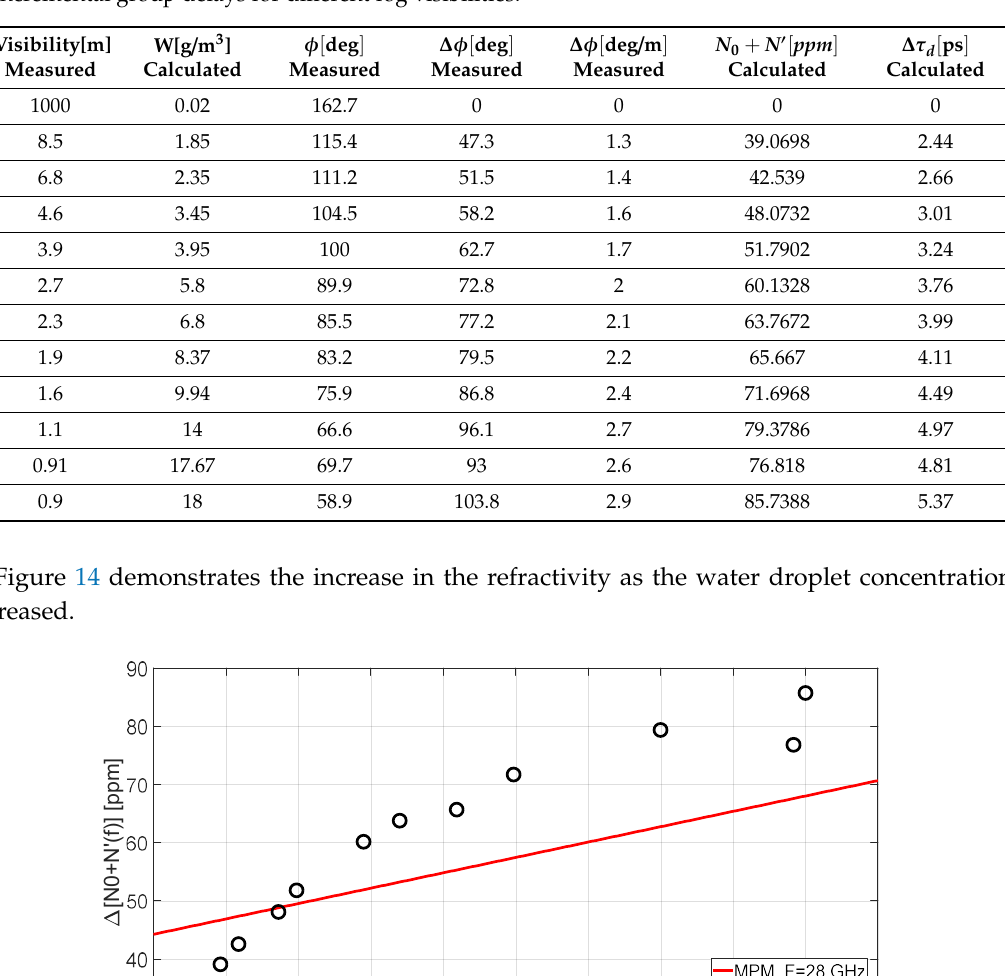
Table 3. Summary of experimentally measured phase shift and resulted refractivity indexes and incremental group delays for di ff erent fog visibilities.